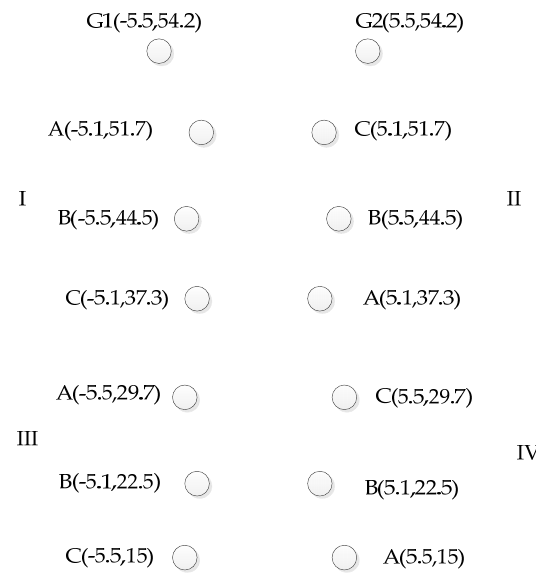
Figure B1. Four-circuit lines on the same tower conductor arrangement diagram. Figure A1. Four-circuit lines on the same tower conductor arrangement